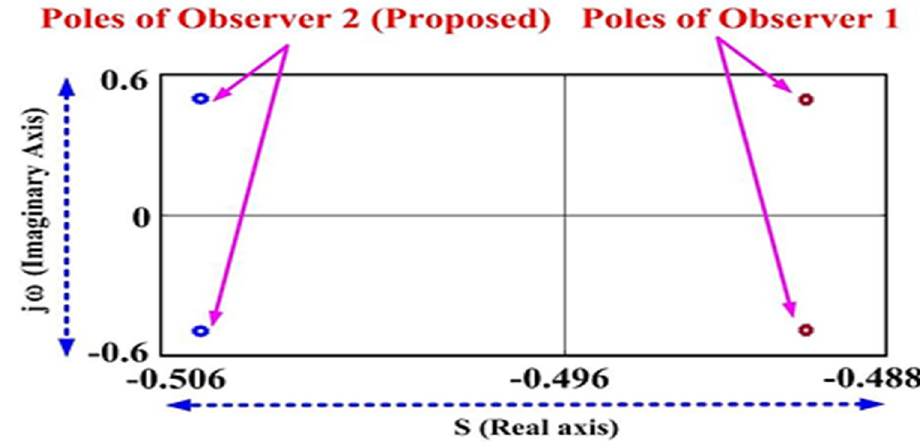
Figure 16. Estimated speed: ( a ) for a constant speed reference of 100 rad/sec for SMLO1, ( b ) for a step speed reference of 40–140 rad/sec for SMLO1, ( c ) for a constant speed reference of 100 rad/sec for